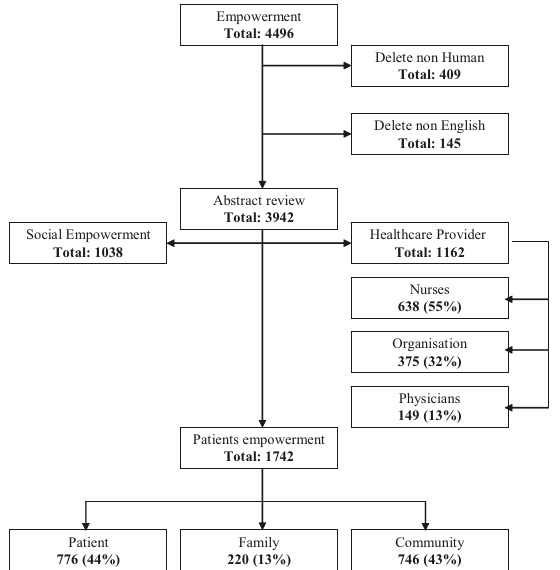
Figure 1. Selection of the abstracts in the literature